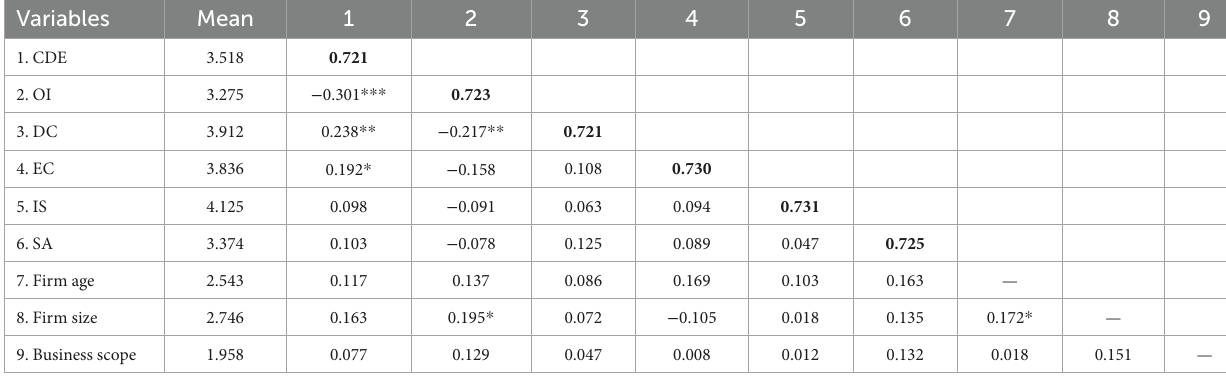
TABLE 3 The results of discriminate